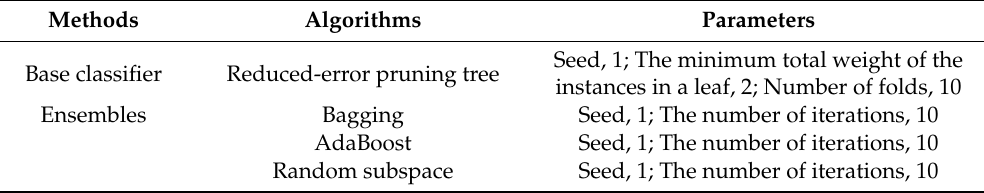
Table 4. Parameters of algorithms utilized in this study.